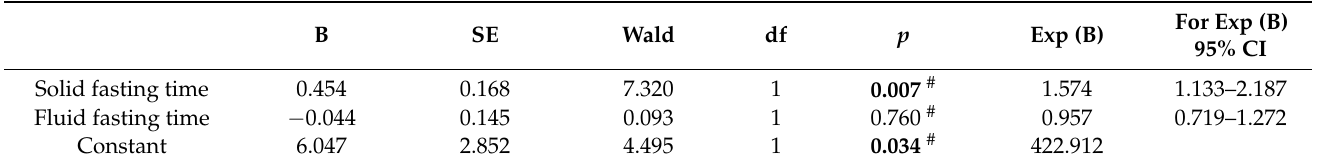
Table 4. Factors affecting the presence of emergence delirium.